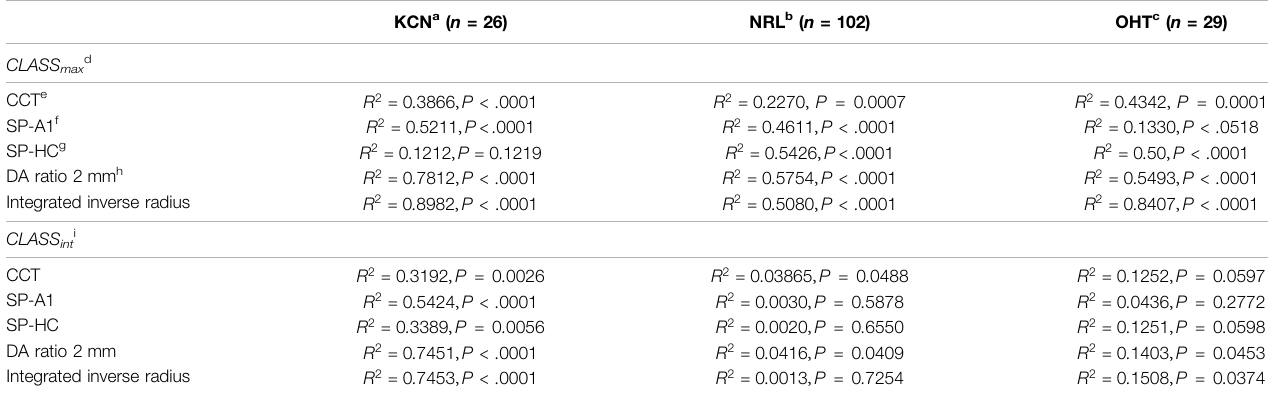
TABLE 4 | Regression analysis results for CLASS max and CLASS int vs. stiffness parameters.